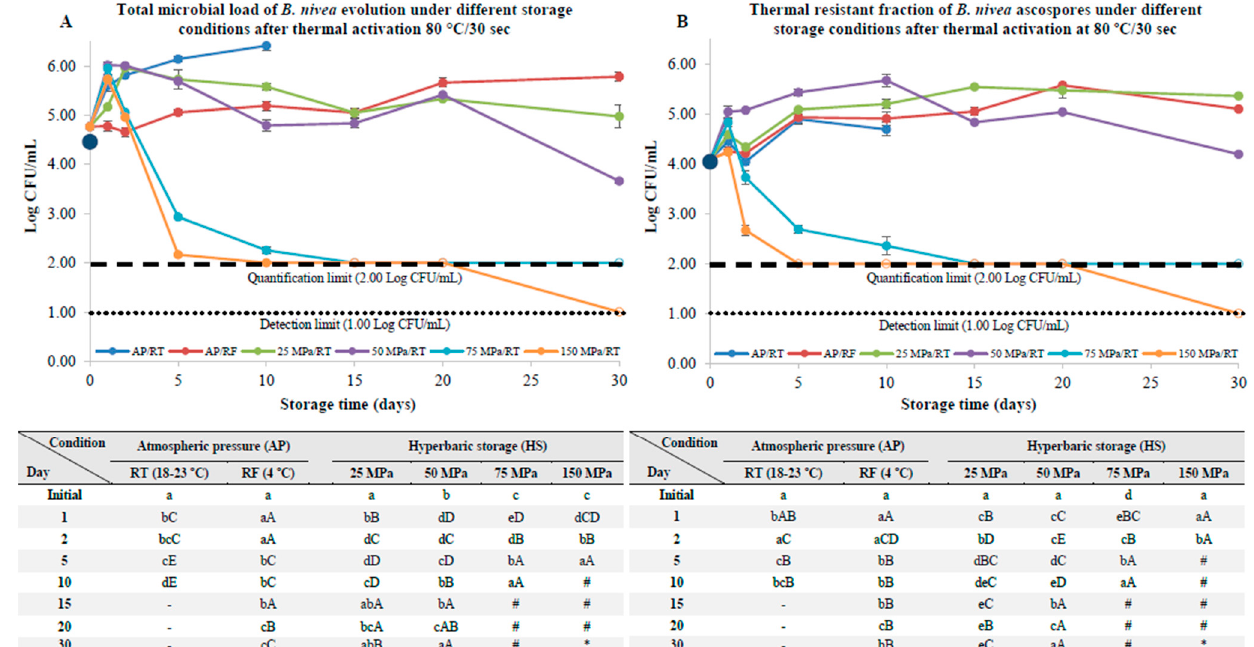
Figure 4. Total microbial load (unheated samples, ( A )) and thermal resistant ascospore fraction (heat-treated samples at 70 °C for 10 min, ( B )) of B. nivea in commercial apple juice (pH 3.7), stored at atmospheric pressure (AP) and naturally variable/uncontrolled room temperature (18–23 °C, AP/RT), AP and refrigeration (4 °C, AP/RF) and hyperbaric storage (25, 50, 75 and 150 MPa, HS) at naturally variable/uncontrolled RT, without a thermal activation step at 80 °C for 30 s. Different lower-case letters (a–e) indicate significant differences ( p < 0.05) between storage days, while different upper-case letters (A–C) indicate significant differences between storage conditions (for a given day). Cases marked with “-” indicate samples not analyzed due to severe spoilage, and with “#” and with “*” refer to samples that reached the quantification limit (of 2.00 Log CFU/mL) and the detection limit (1.00 Log CFU/mL), respectively. The dark and larger circle at the Y axis represents the initial load before the thermal pre-activation step at 80 °C/30 s. The dashed and dotted lines indicate the quantification and detection limits that were reached, respectively.